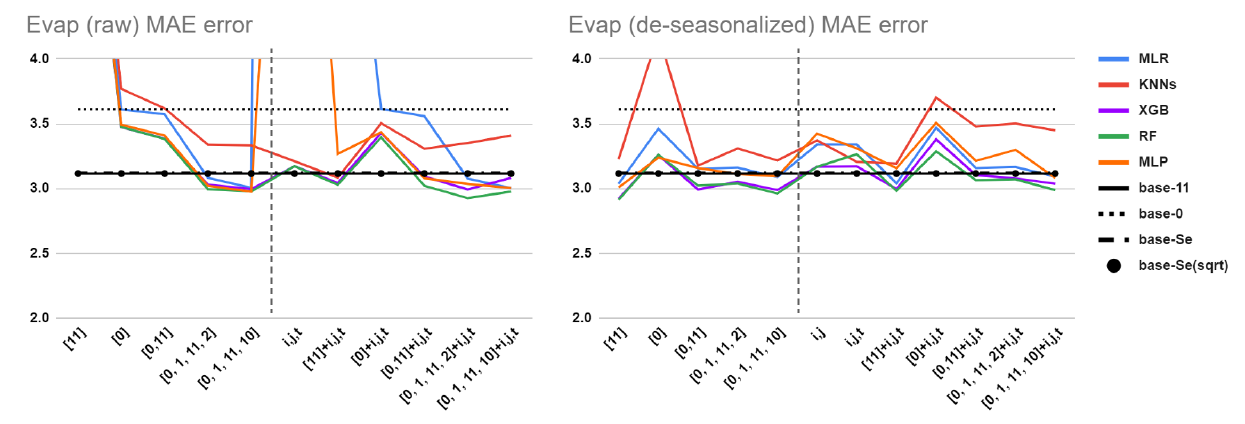
Figure 8. MAE for evaporation predictions with different feature sets, for raw and de-seasonalized data sets.